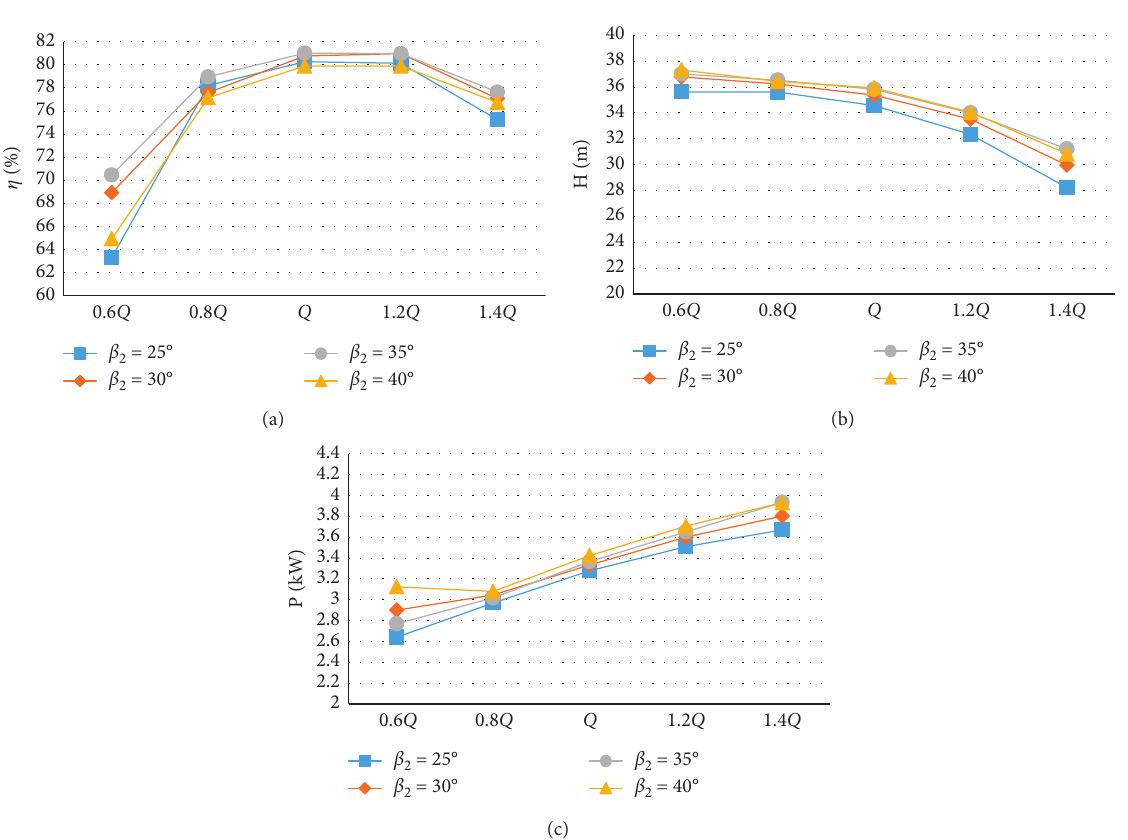
Figure 11: External characteristic curve of the impeller model with different outlet